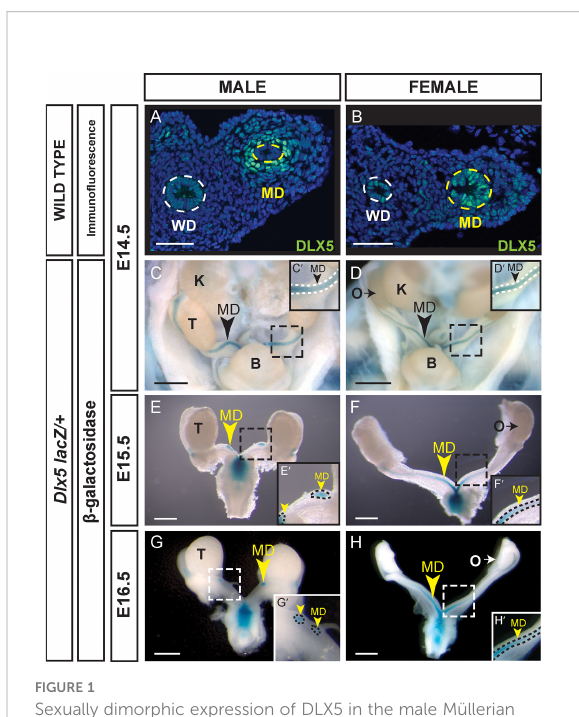
FIGURE 1 Sexually dimorphic expression of DLX5 in the male Müllerian duct mesenchyme and female Müllerian duct epithelium. Immuno fl uorescent staining of DLX5 in cross sections of the mesonephros from E14.5 male (A) and female (B) embryos. Dotted lines surround MD and Wolf fi an duct (WD) epithelium. Scale bars = 50 µm. Dlx5-lacZ expression in male MD is lost as MD regresses. b -gal-stained urogenital organs from E14.5 to 16.5 Dlx5-lacZ heterozygous male (C, E, G) and female (D, F, H) embryos. Dashed square boxes show location of higher magni fi cation insets. Arrowheads, Müllerian ducts. MD, Müllerian duct; WD, Wolf fi an duct; B, bladder; K, kidney; O, ovary; T, testis. Scale bars = 500 µm. (C ’ - H ’ ) Higher magni fi cation insets. Arrowheads, Müllerian ducts. MD. Dotted lines surround MD. Each sex and genotype analyzed n ≥